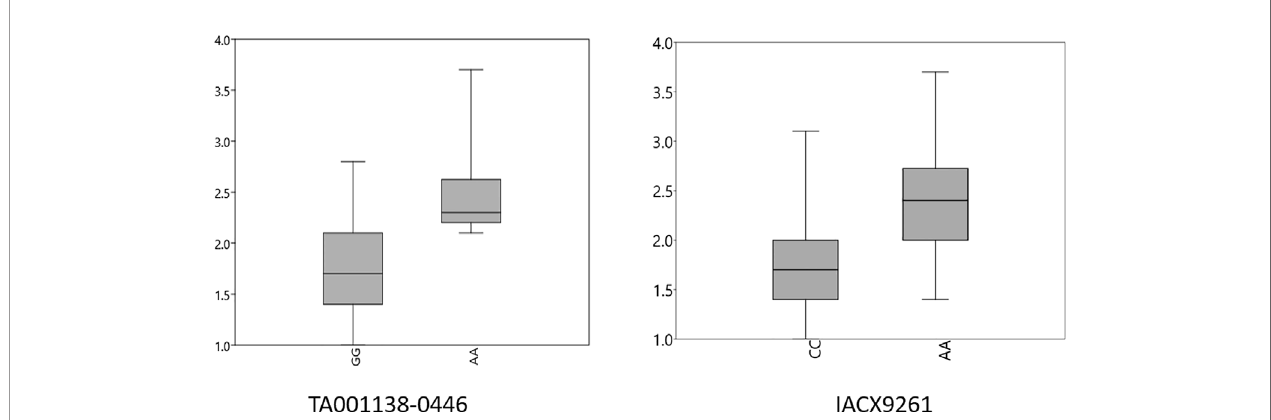
FIGURE 5 | Box plots for effects of resistant and susceptible alleles on average tan spot score for stable MTAs. Foot note: X axis — resistant and susceptible allele, Y axis — average tan